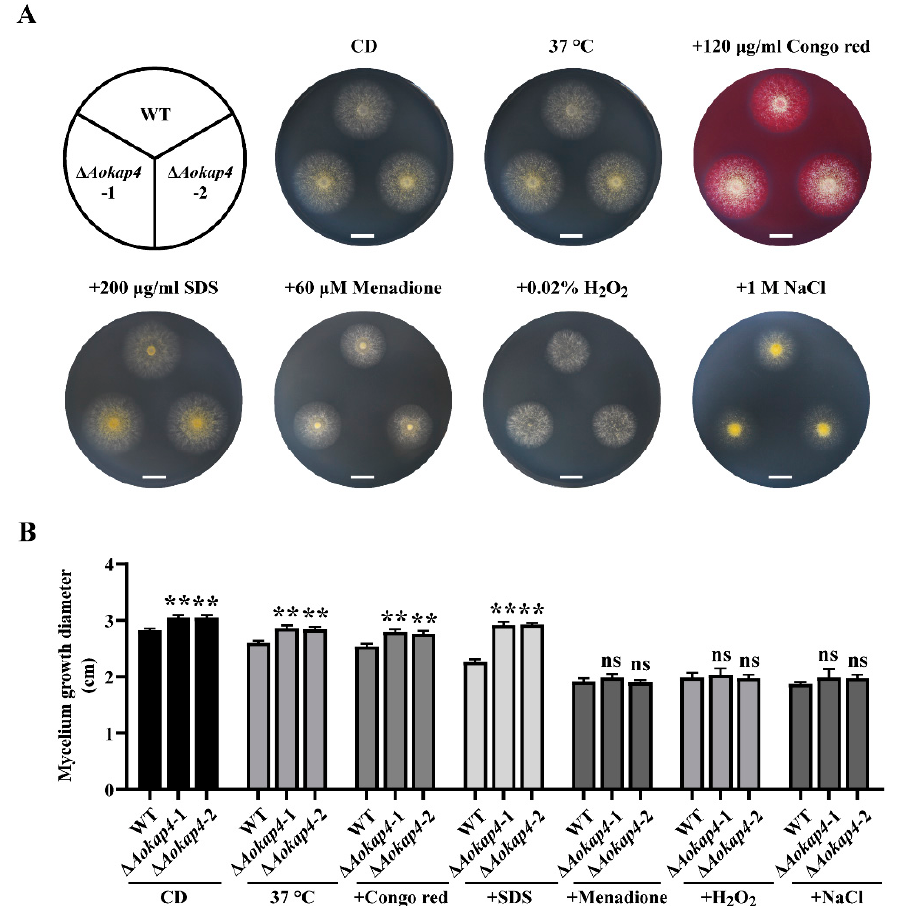
Figure 3. Phenotypical comparison of the wild-type and Aokap4- deletion strains under stress. ( A ) Colony growth of the wild-type and Aokap4- deletion strains on the CD agar medium with 120 µ g/mL Congo red, 200 µ g/mL SDS, 60 µ g/mL menadione, 0.02% H 2 O 2 and 1 M NaCl for three days at 30 ◦ C. For heat stress, the plates were incubated at 37 ◦ C. ( B ) Colony diameter of the wild-type and Aokap4- deletion strains under stress. The colony diameter of the wild-type and Aokap4- deletion strains cultivated on CD plates for three days under stress was measured. Asterisks indicate statistical significance in the differences between the WT and Aokap4- deletion strains based on Student’s t -tests (** p < 0.01; ns, no significant difference). Scale bars = 1 cm.